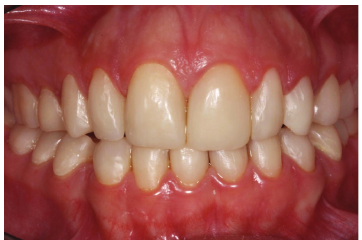
Figure 5: Follow-up after 18